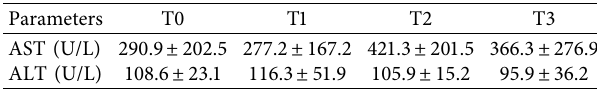
Table 1: The concentration of AST and ALT in the male rats after administering the neem leaf ethanol